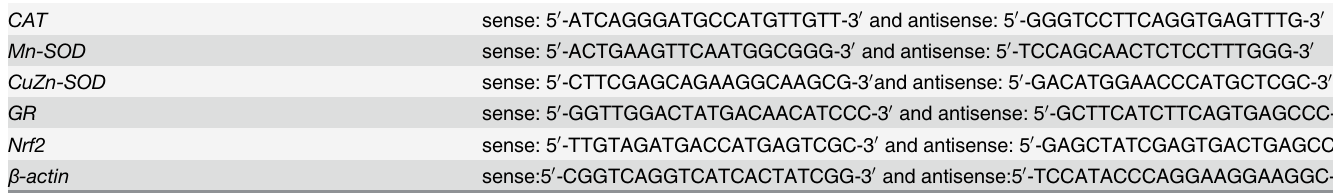
Table 2. Primer sequences used in